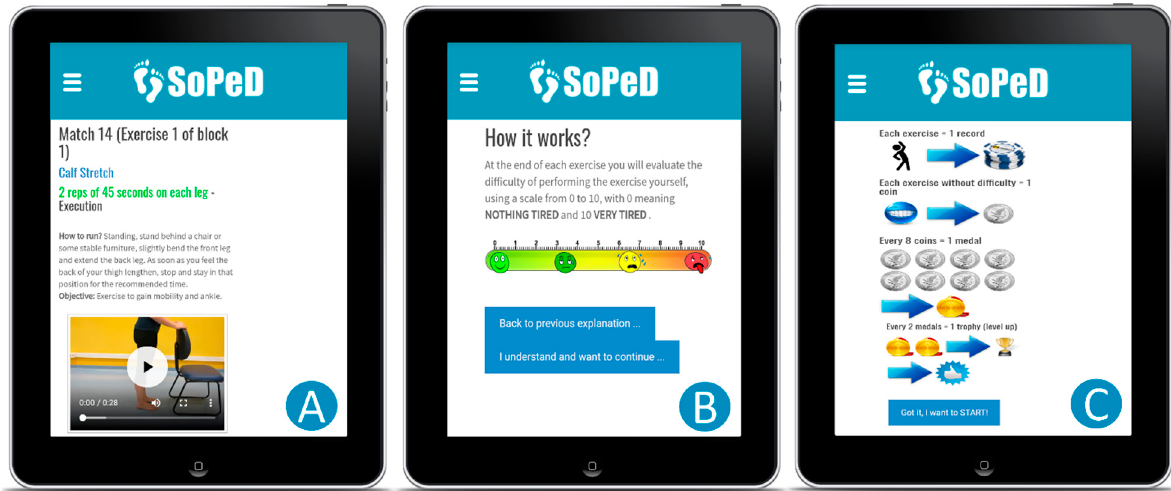
Figure 2. Sistema de Orientação ao Pé Diabético (SOPeD; translation: Diabetic Foot Guidance System). ( A ) Layout of the exercises page with video, audio, and written instructions. ( B ) Perceived effort scale to be completed after each exercise performed. ( C ) Exercise protocol rules with gamification components.